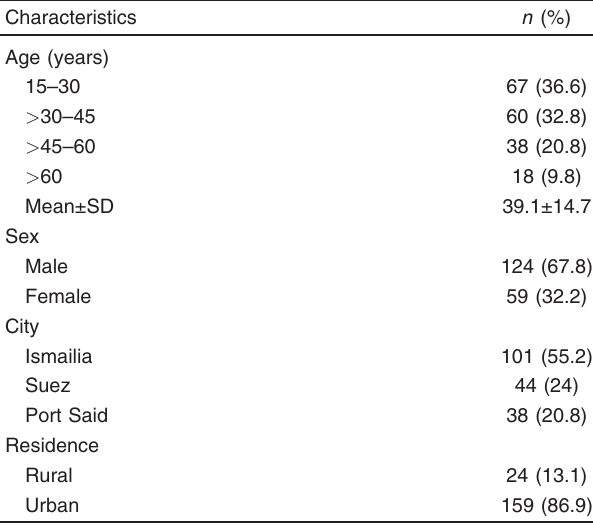
Table 1 Sociodemographic characteristics of studied patients (age, sex, city, and residence) ( N = 183)